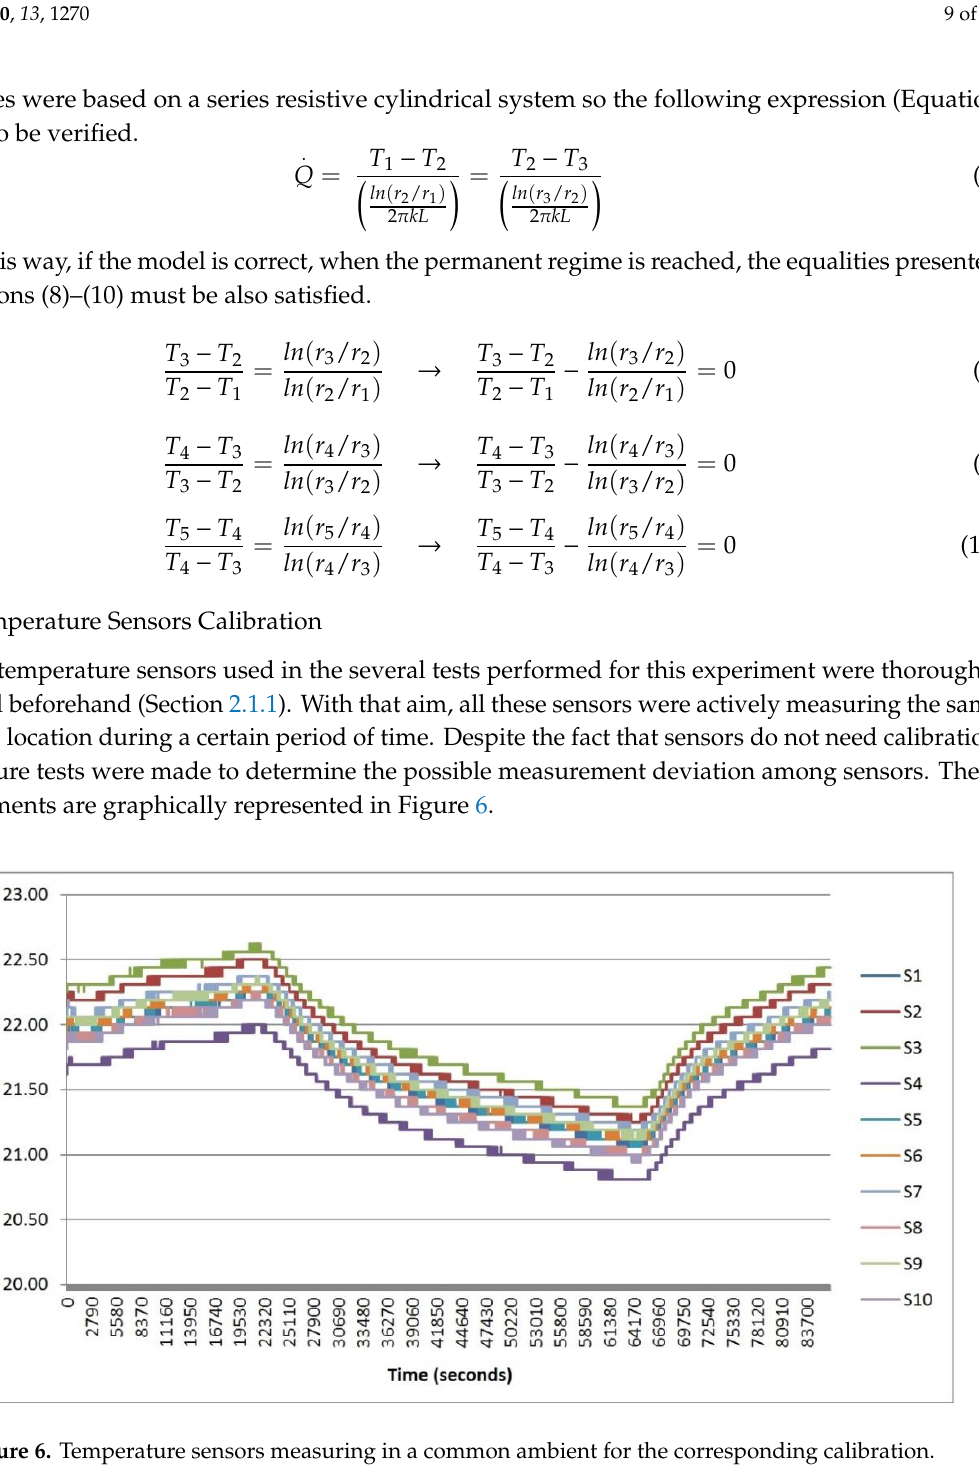
Table 2. Correction factors to be implemented in the temperature measurement of each sensor.